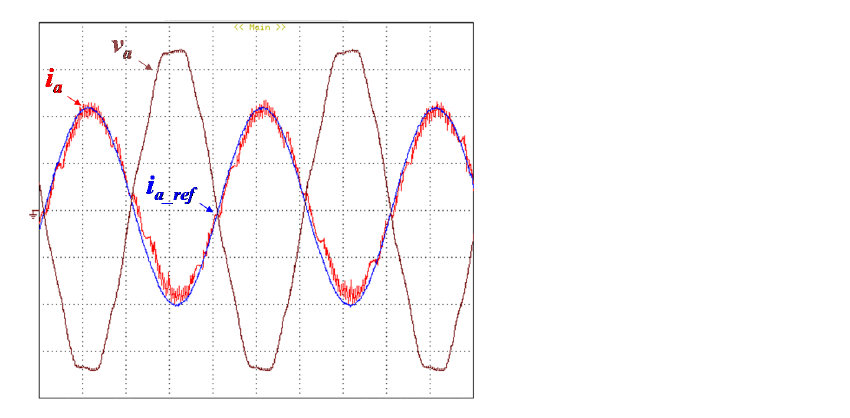
Figure 37. Power grid voltage ( v a ), current ( i a ), and reference current ( i a_ref ) in V2G mode (current: 2 A; voltage: 20 V/div; time: 5 ms/div).